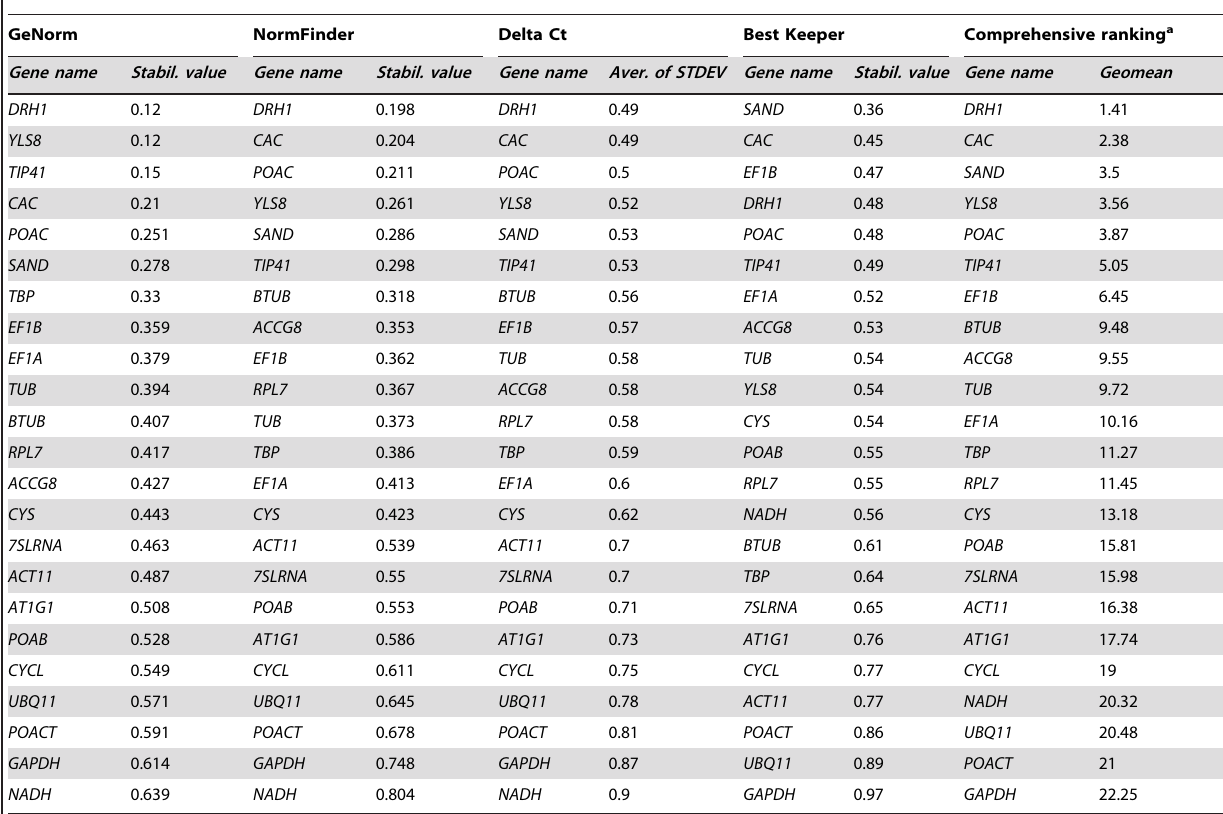
Table 2. Integrated table of reference gene expression stability values based on different algorithms.